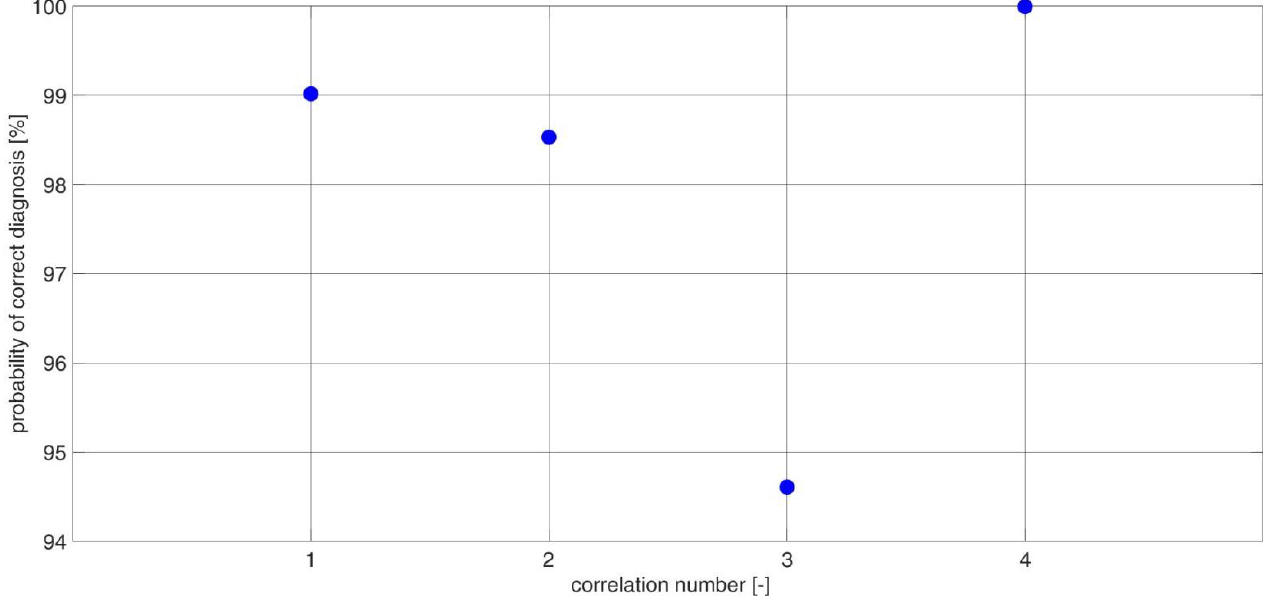
Figure 8. The overall probabilities of correct diagnoses for outer race diagnosis via CCSM3 for each correlation number (Table A2).